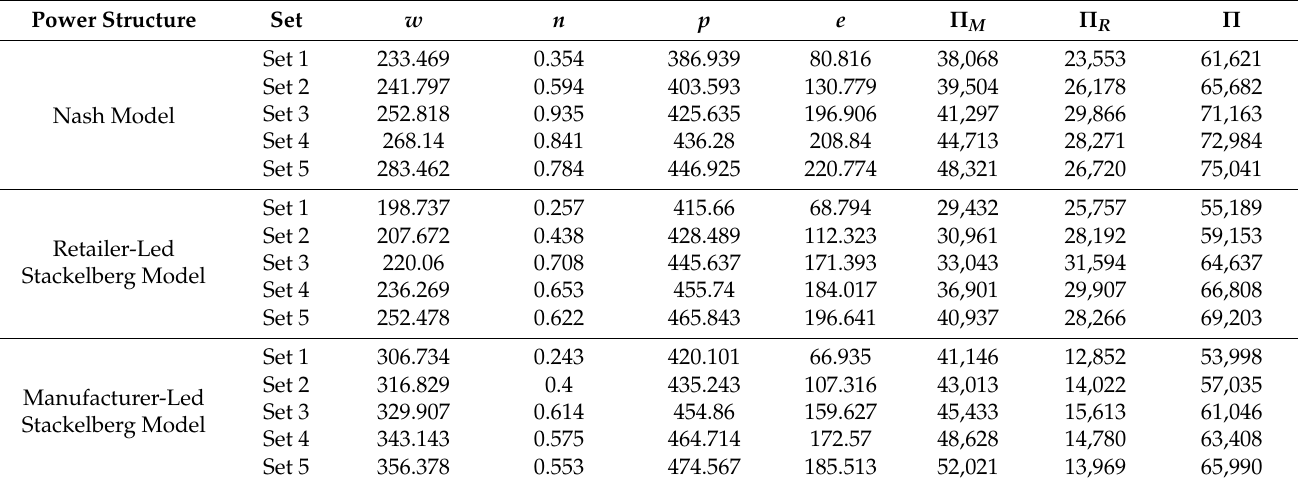
Table 3. The optimal solution in the different power